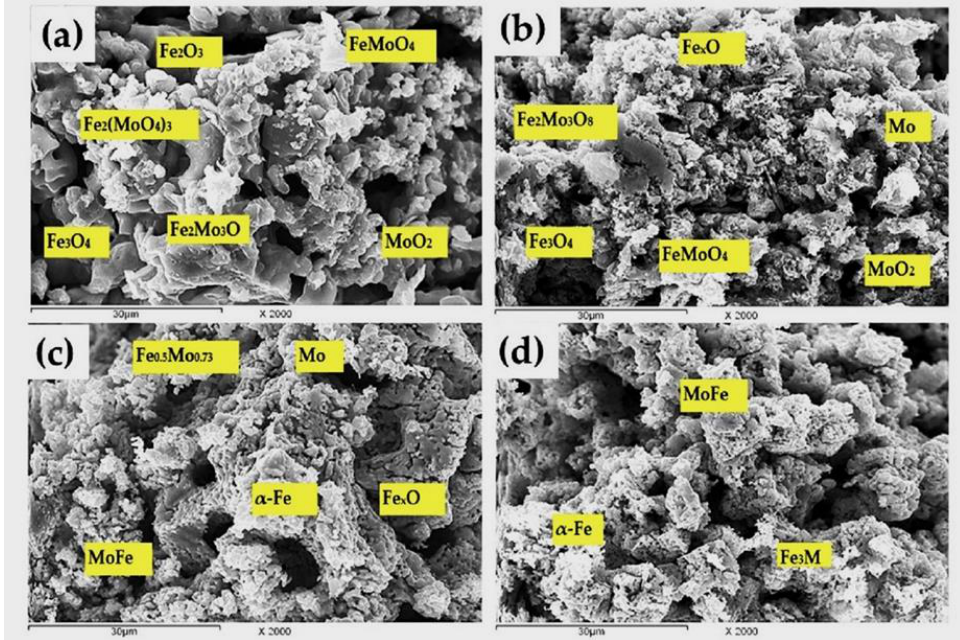
Figure 6. SEM images analysis for precursors (B) reduced at 750 °C with H 2 up to ( a ) 20%; (b ) 60%; ( c ) 85%; and ( d ) 100% degrees.